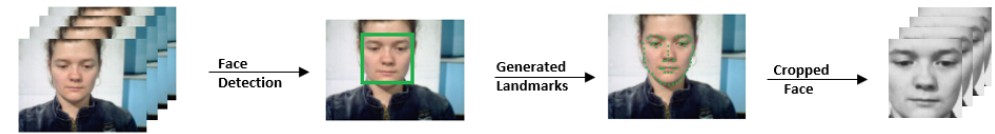
Figure 1. The workflow of pre-processing